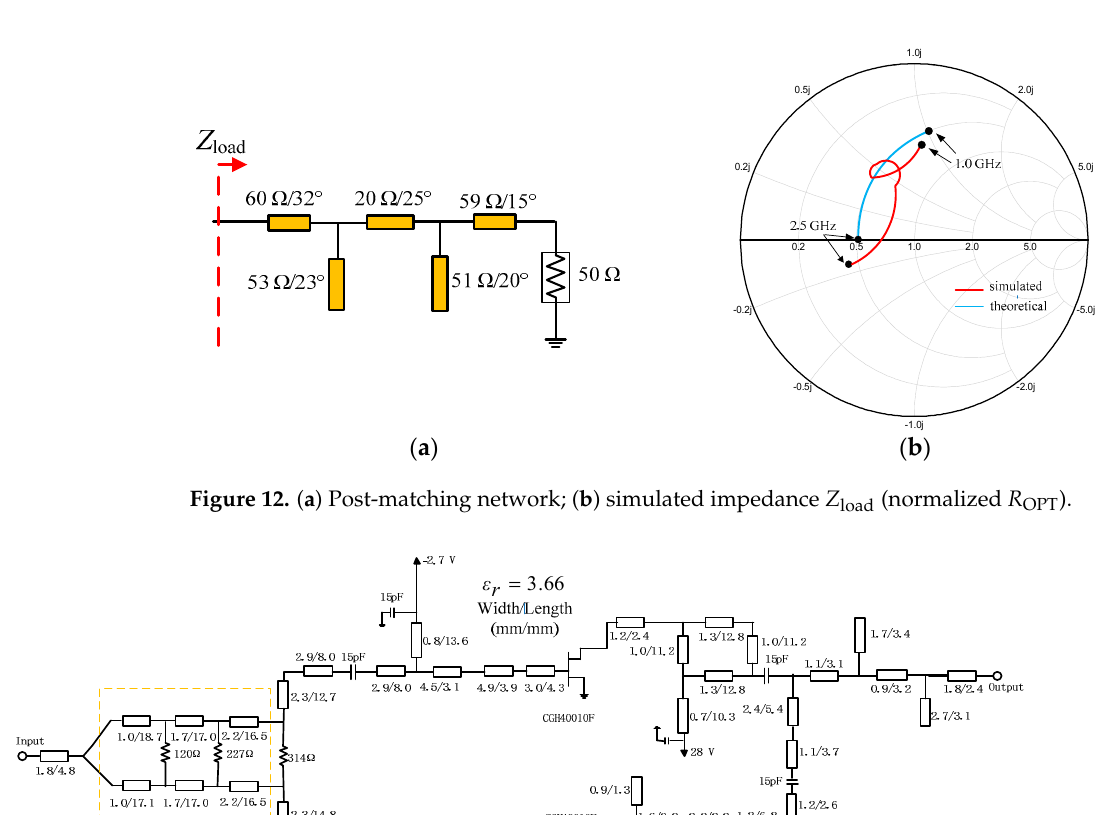
Figure 12. ( a ) Post-matching network; ( b ) simulated impedance Z load (normalized R OPT ).